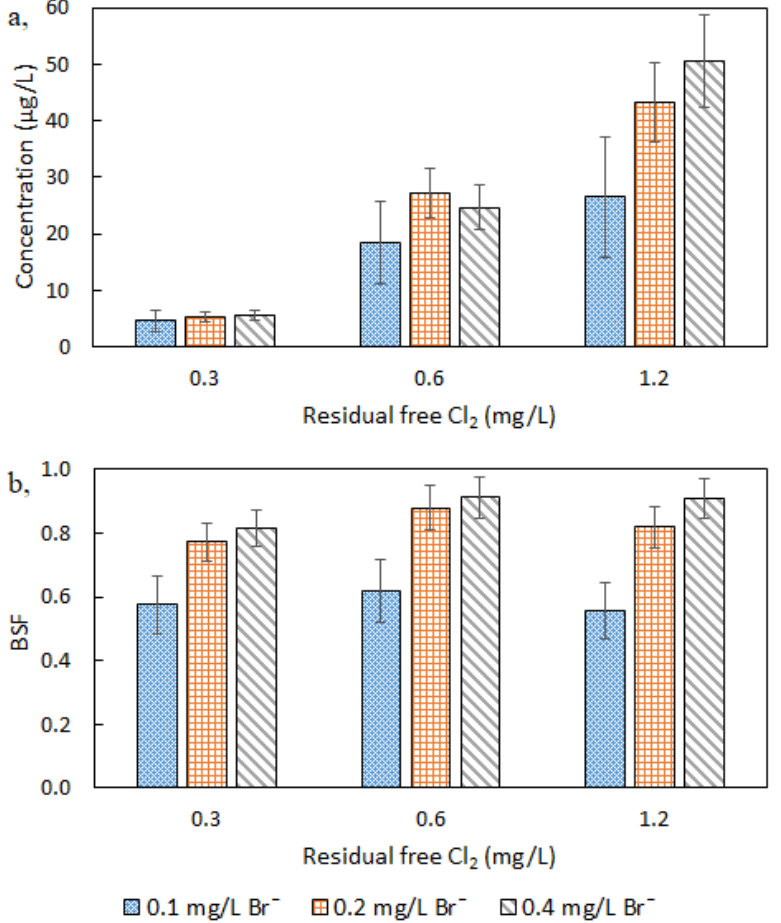
Figure 6. The effect of Br − concentration and residual free Cl 2 in raw water on the ( a ) concentration and ( b ) distribution of THMs at bench-scale disinfection experiments.